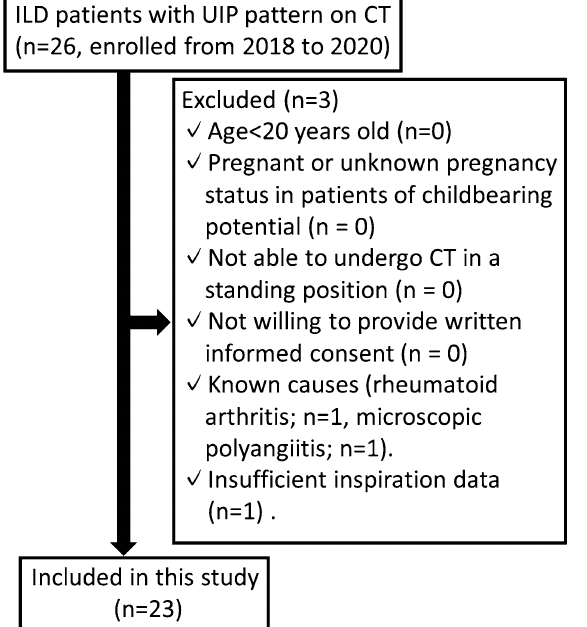
Figure 1. Flowchart of participant inclusion and exclusion. ILD interstitial lung disease, UIP usual interstitial pneumonia, CT computed